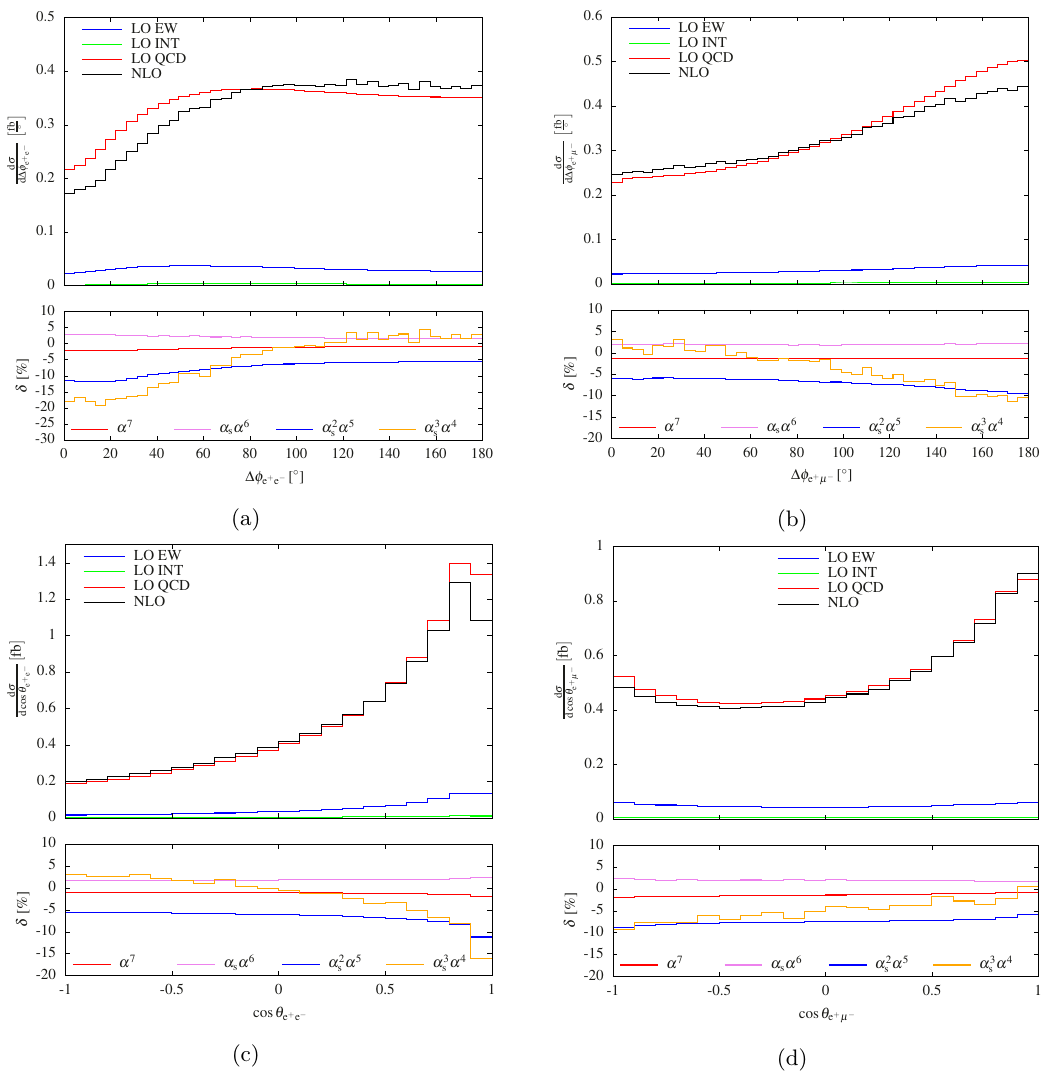
Figure 7 . Same as for figure 4 but for the observables: azimuthal angle between the positron and the electron (top left), azimuthal angle between the positron and the muon (top right), cosine of the angle between the positron and the electron (bottom left), and cosine of the angle between the positron and the muon (bottom